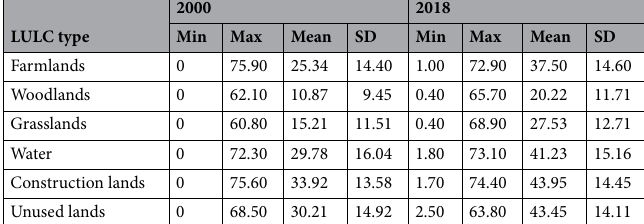
Table 2. PM 2.5 concentrations of different the LULC types (units: μg/m 3 ).